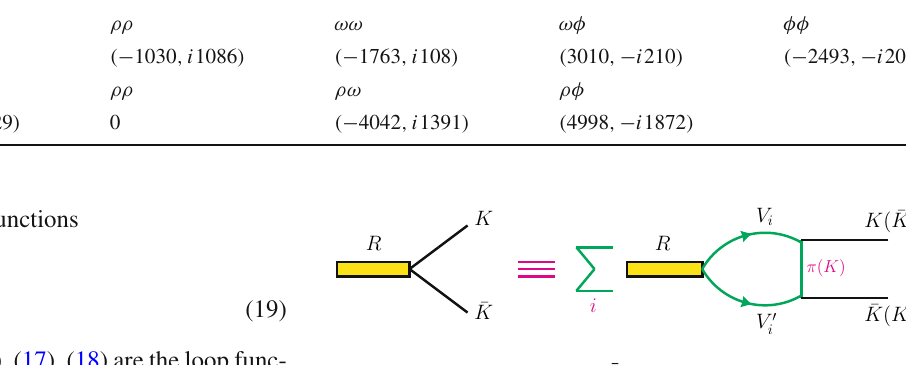
Table 1 Couplings of f 0 ( 1710 ) and a 0 ( 1710 ) to V V channels. All quantities are in units of MeV